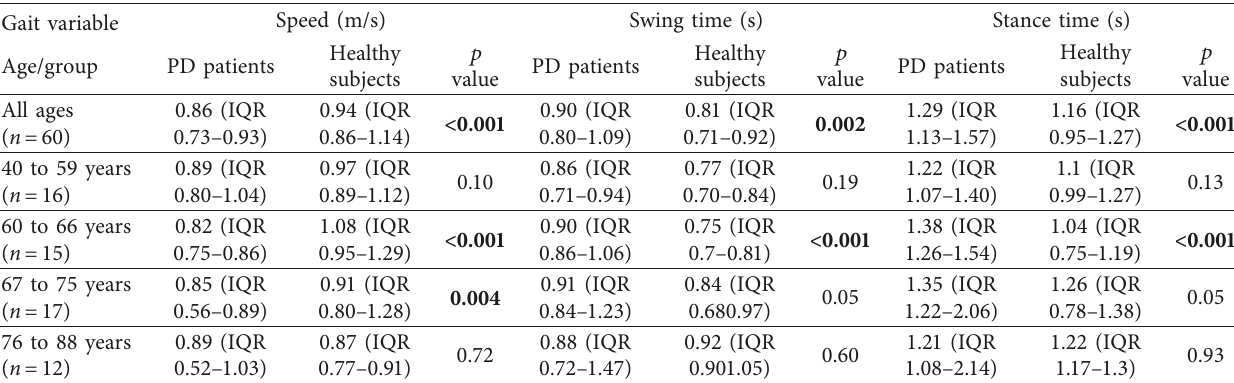
Table 3: Spatiotemporal gait parameters obtained from the e-motion capture system in the PD patient group and the healthy subjects group. Gait variable